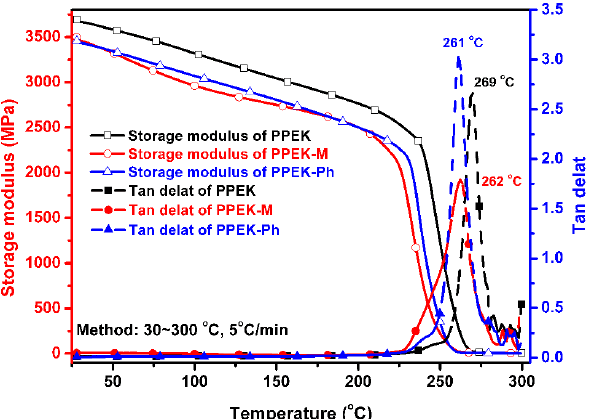
Figure 6. Storage modulus and tan δ curves of the PPEKs resins, as a function of temperature measured by dynamic thermomechanical analysis (DMA) in air, from 30 to 300 °C. Table 5. Storage modulus and Tg values of the resins measured by DMA